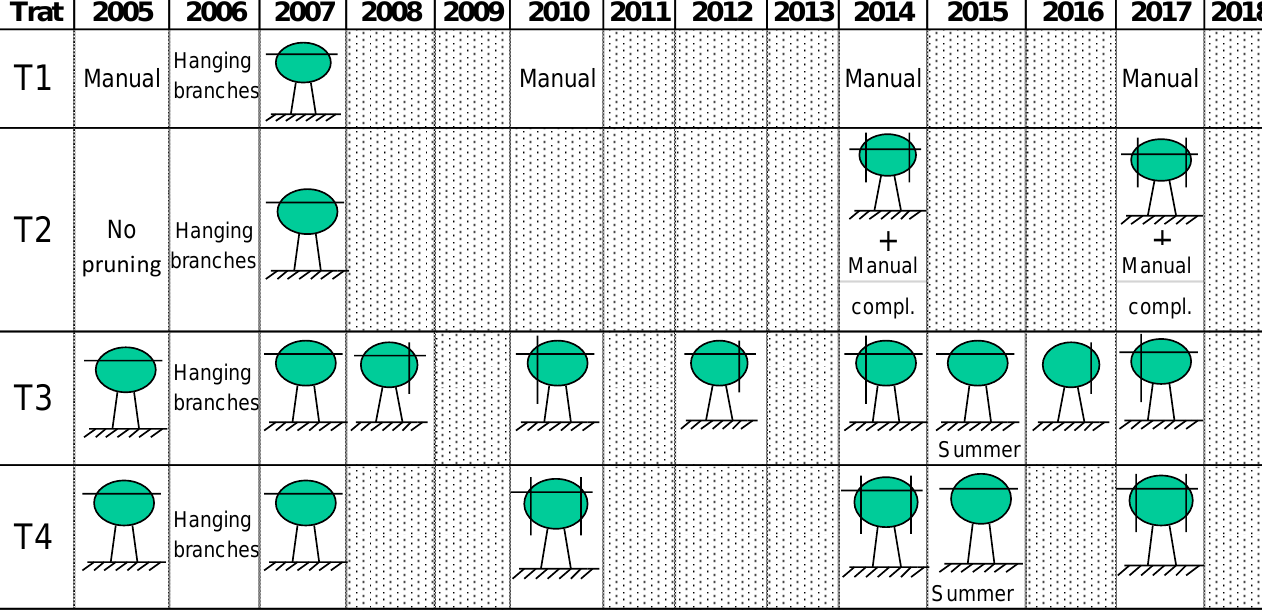
Figure 2. Sequence of pruning interventions.